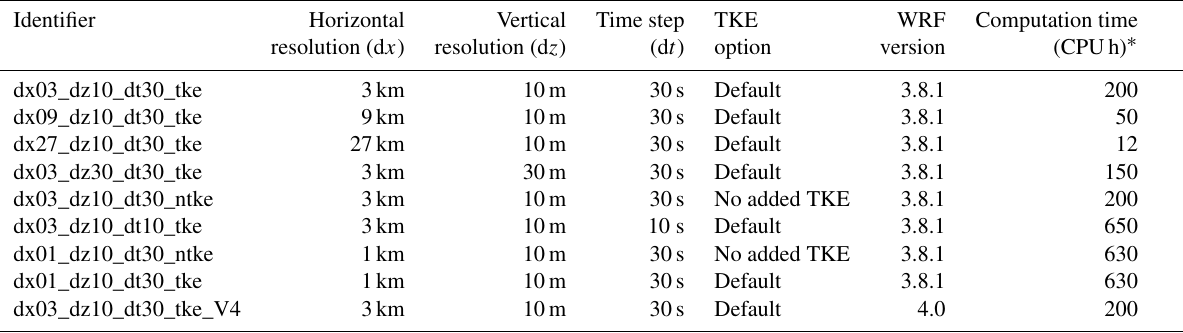
Table 2. Simulation